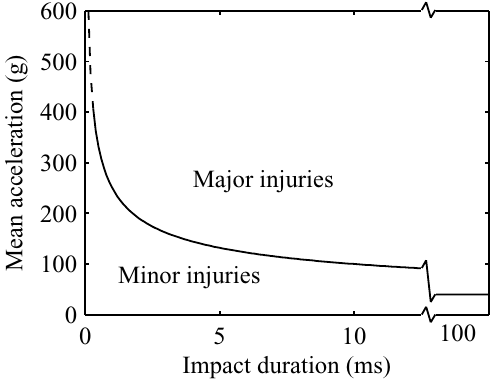
Fig. 1. Wayne State University Cerebral Concussion Tolerance